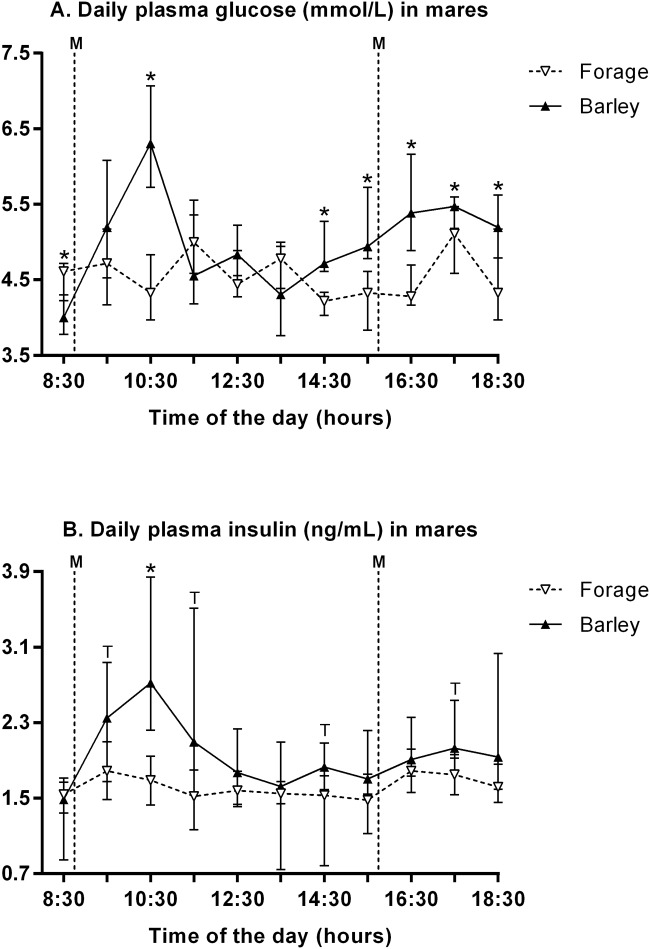
Mares’ plasma glucose (A) and insulin (B) concentrations (median and IQR) over a 10-hour monitoring period a fortnight after start of the diet.M: meals. Values under the asterisks significantly differ and those under letter “T” tend to differ between both groups (Mann-Whitney with FDR adjustment).